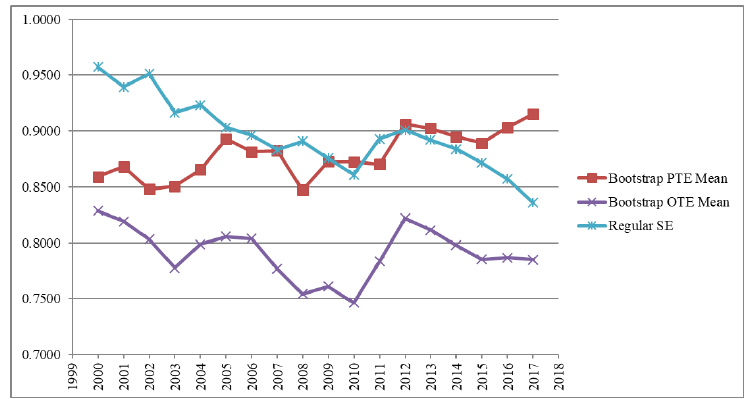
Figure 3. Annual bootstrap OTE, bootstrap PTE, and the SE for the second stage.